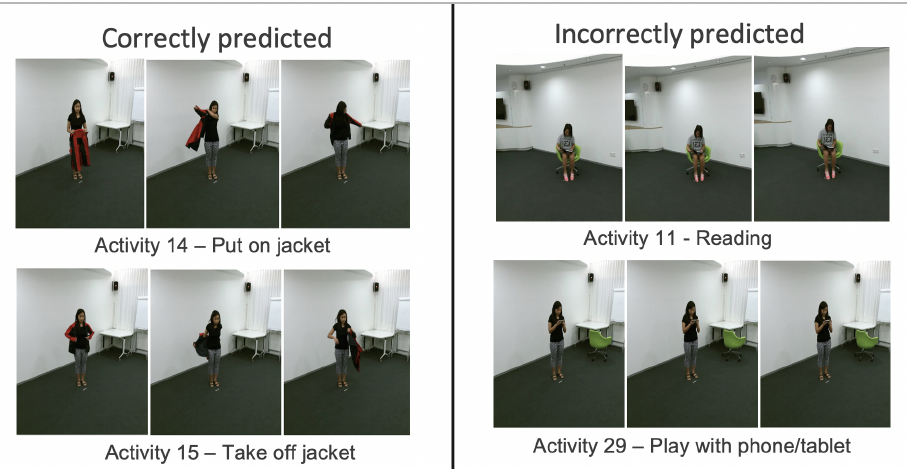
Figure 12. Correctly predicted ( left ) and incorrectly predicted ( right ) examples recognised by the proposed network.